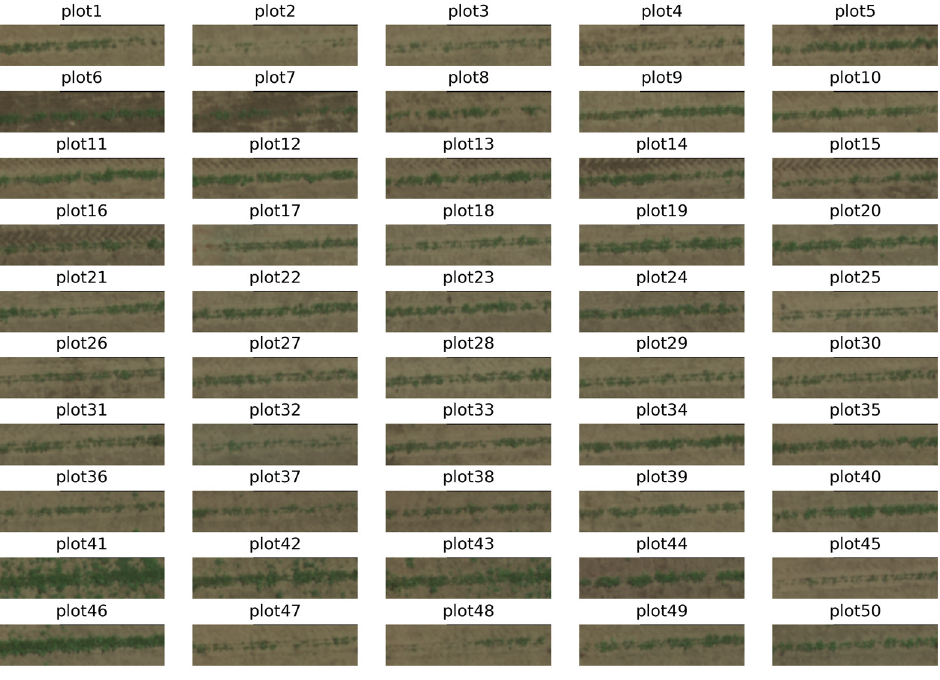
Figure 2. RGB (color) bands of MicaSense plot imagery from 9 July 2018 at 11:00. Note the broad range in crop emergence at this early season observation. Each plot is 3 × 0.6 m in dimension and has a 0.02 m ground sampling distance.